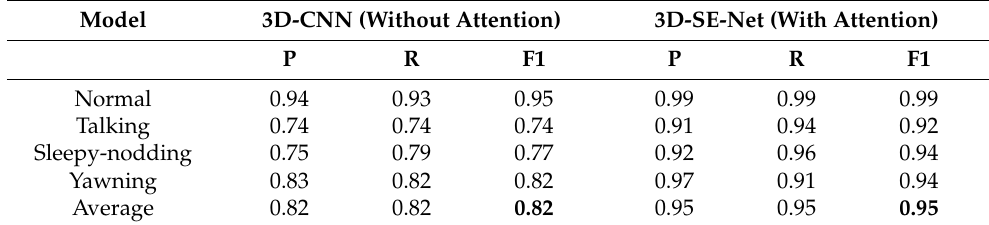
Table 2. Performance evaluation results on the FDF test set.